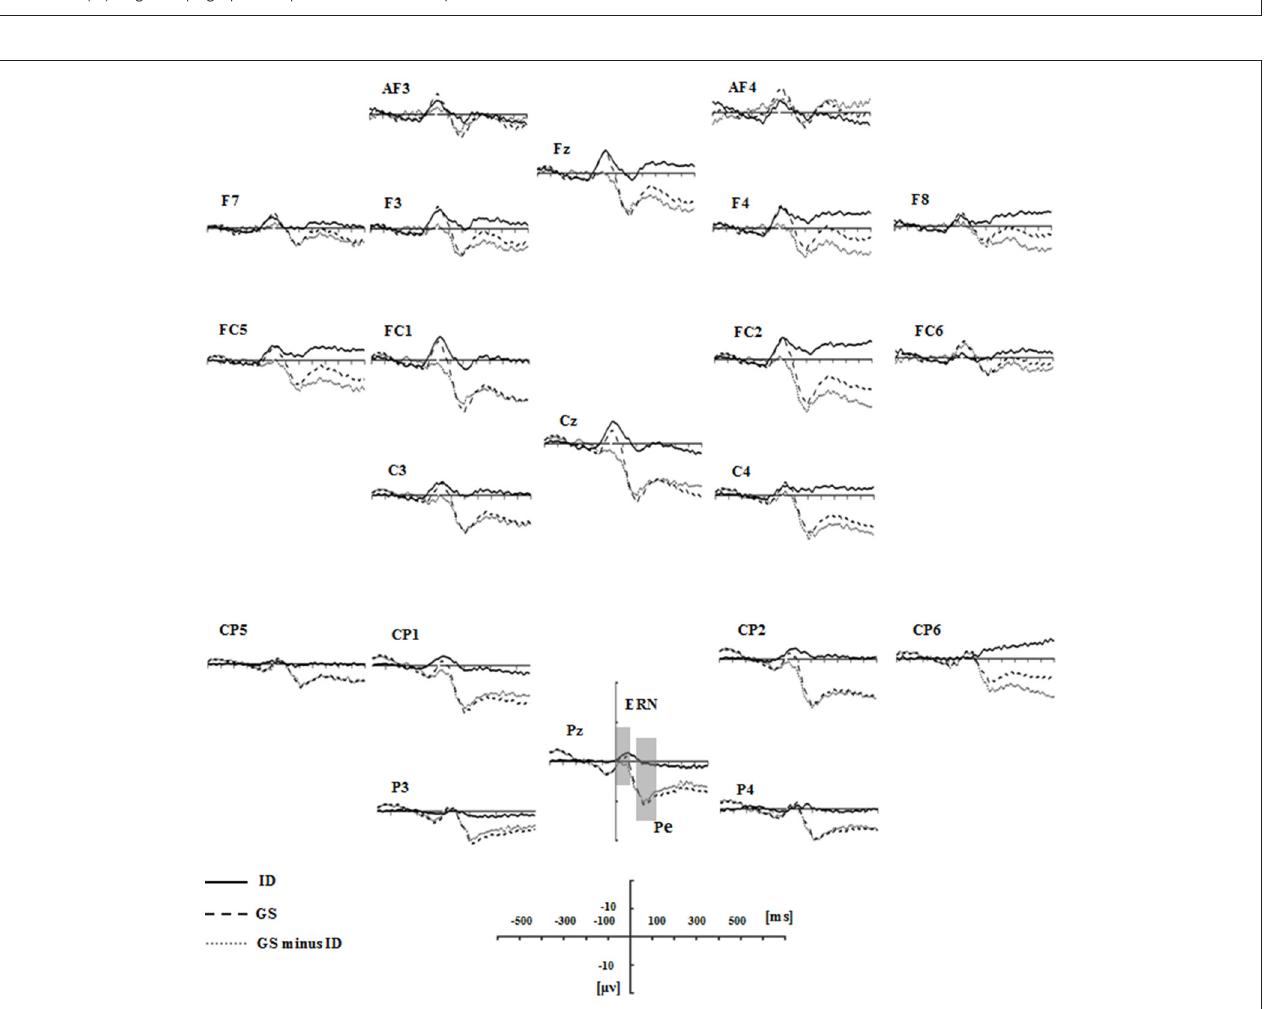
FIGURE 5 | Grand average response-locked ERP waveforms in the failed stop trials for the groups of ID (solid lines), GS (dash lines), and their difference waves (gray dot lines). ERN (0-100ms) and Pe (150–300ms) components were labeled at the site where their peak latencies were determined.